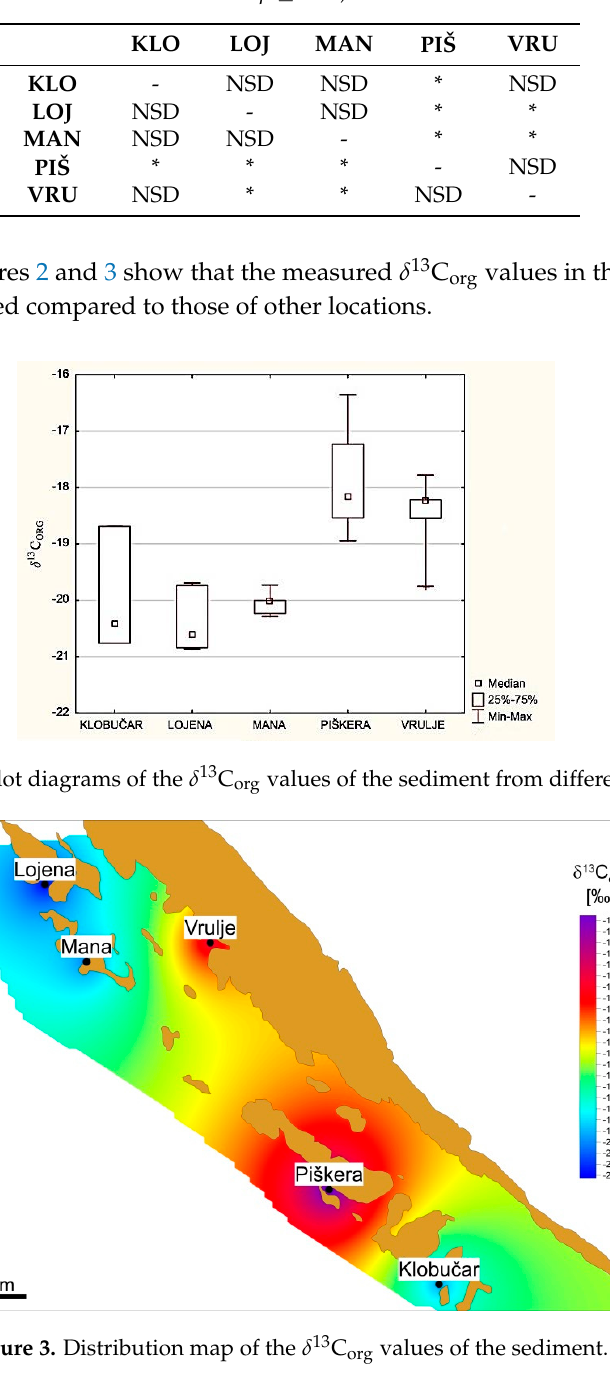
Table 1. Average values of δ 13 C org in the sediment, (n = number of samples collected).